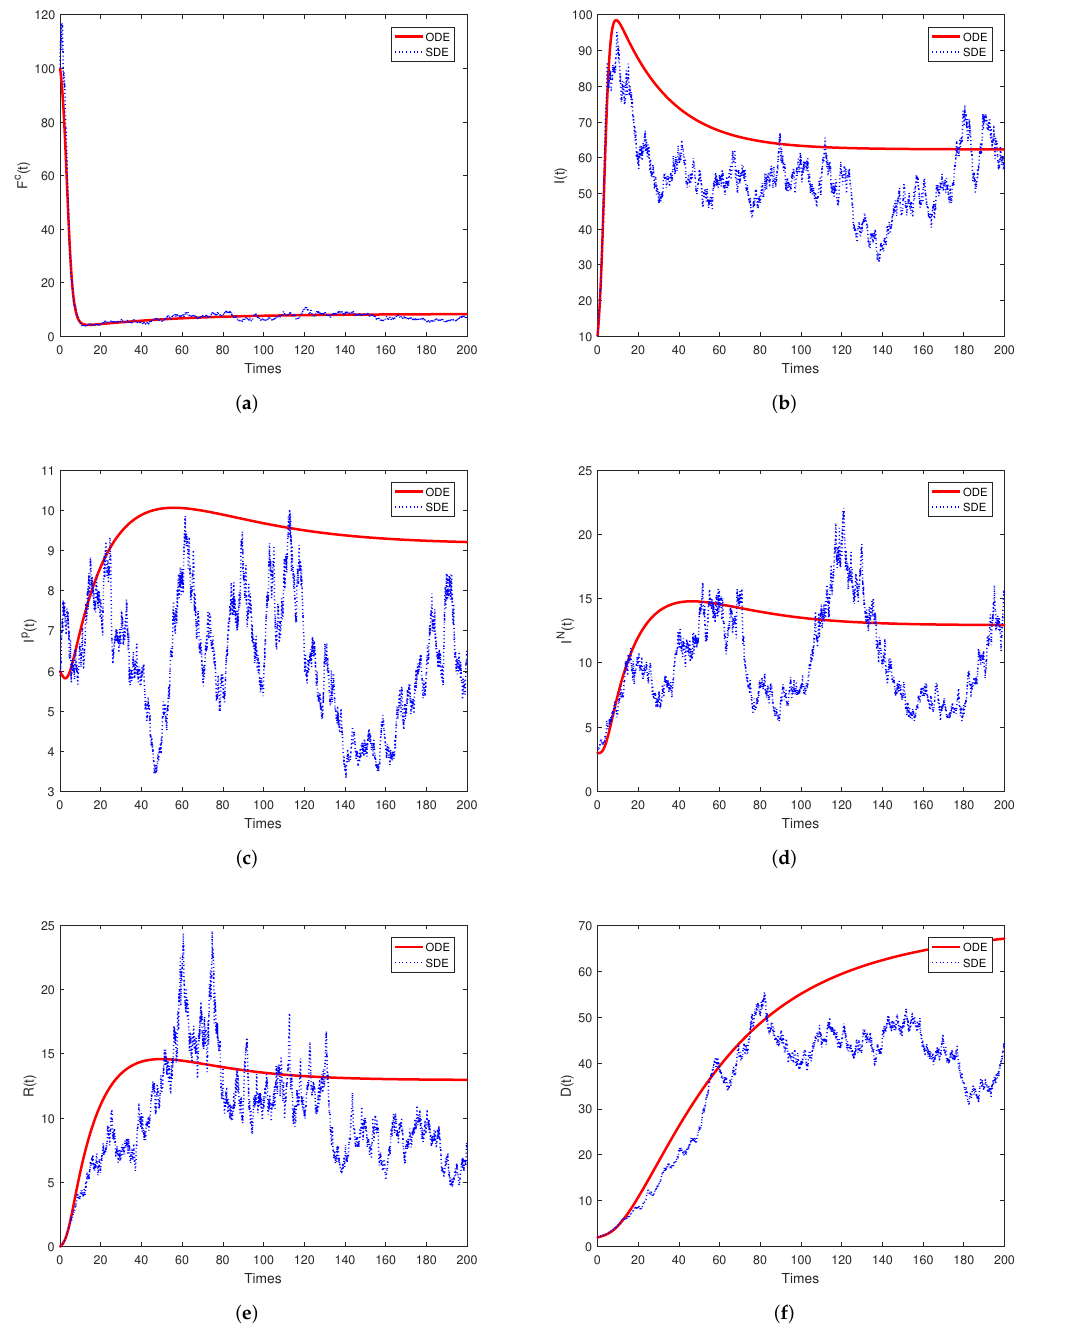
Figure 2. Simulations of ( F c ( t ) , I ( t ) , I P ( t ) , I N ( t ) , R ( t ) , D ( t )) for the stochastic model (1) with its corresponding deterministic version. ( a ) F C ( t ) : researchers using fractional differential operators with non-singular kernels. ( b ) I ( t ) : researchers that have been affected by the harmful papers. ( c ) I P ( t ) : researchers that have been affected, but still have positive opinions about non-singular kernel derivatives. ( d ) I N ( t ) : researchers that have been affected and have negative opinions about non-singular kernel derivatives. ( e ) R ( t ) : researchers that have overcome divisive criticism. ( f ) D ( t ) : researchers that die, or